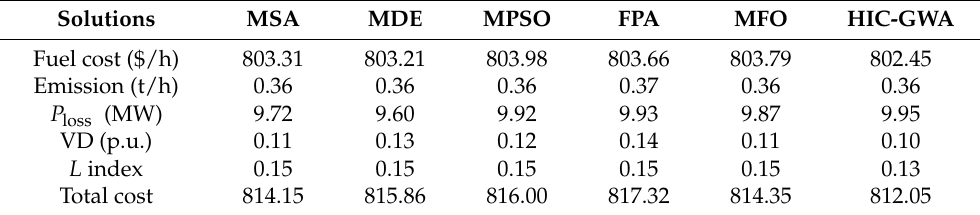
Table 12. Comparison of the proposed approach with different approaches for this case.